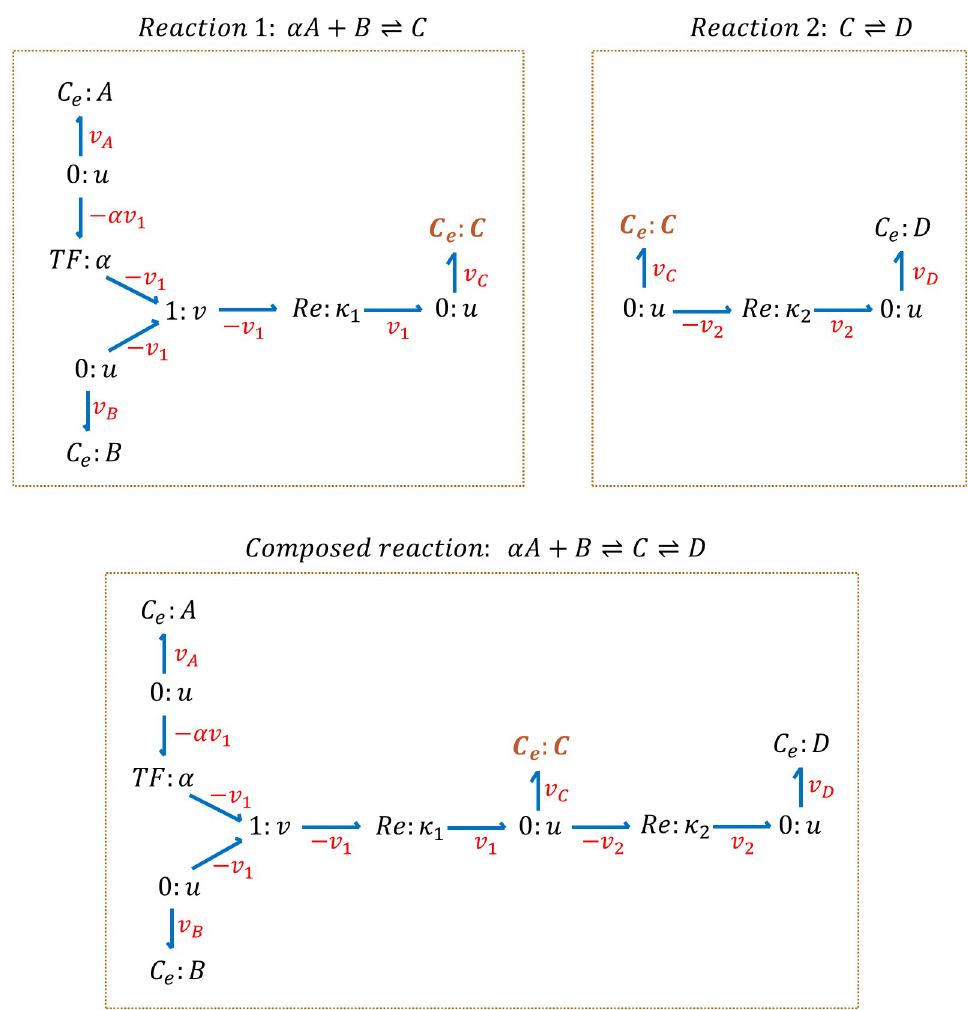
Fig 2. An example of composing two reactions in bond graphs. Reactions 1 and 2 represent two separate reactions in which the species C is common. To compose the reactions, the common species (C) is merged and the conservation equation at its corresponding ‘0: u ’ junction alters to account for the imposed changes in structure. The conservation equation at the ‘0: u ’ junction connected to the species C is v c = v 1 in Reaction 1 and in Reaction 2 is v C = − v 2 and in the composed reaction it changes to v = v 1 − v 2 C